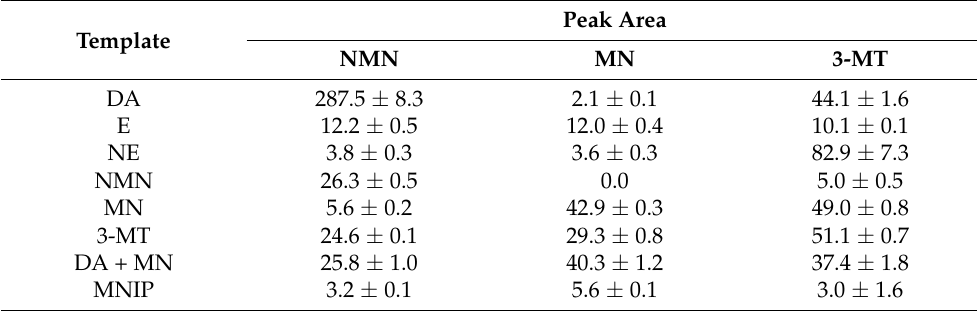
Table 2. Enrichment results of spot urine samples by MMIP synthesized with different template molecules. ( x ± s , n =